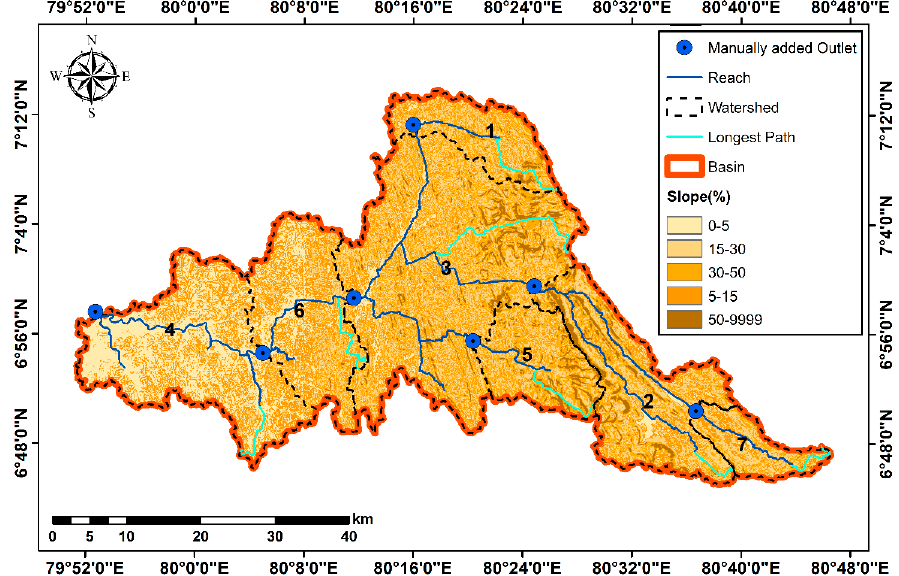
Figure 3. Watershed model development (SWAT watershed delineation map showing the sub-ba-